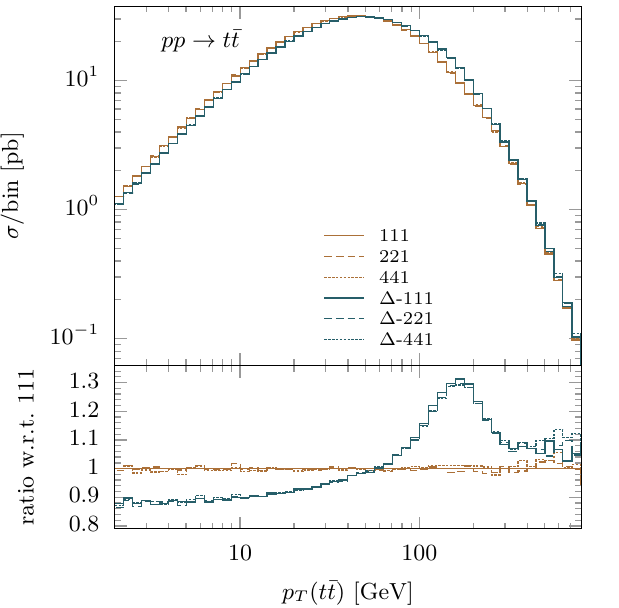
Figure 5 . As in (cid:12)gure 2, for the transverse momentum of the t (cid:22) t pair, for the process in eq. (5.13). anticipate (see (cid:12)gure 6) that this is not the signal of a genuine discrepancy between the two prescriptions, but it rather re(cid:13)ects a matching uncertainty that a(cid:11)ects both matching techniques in a similar manner. The large- p region also exhibits some of the features T relevant to W + t (cid:22) t production that we have described in (cid:12)gure 4; they are however milder here, owing to the distribution being less steep and the (cid:12)nal-state less massive than in